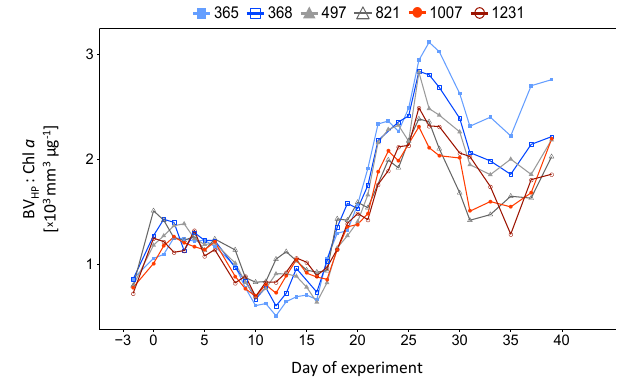
Figure 5. Ratio of heterotrophic prokaryotic biovolume and Chl a (BV HP :Chl a) during the course of the experiment. PA BV HP was interpolated using splines with software R (R Core Team, 2016) for time-points, where no data were available. Colours and symbols indicate average f CO 2 [µatm] between t 1 and t